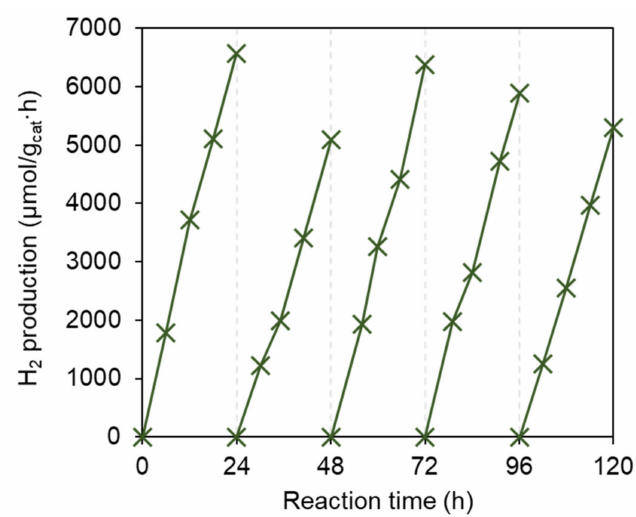
Figure 7. Recycle test showing hydrogen production results for B-Car / Pt-TiO 2 . Conditions: Xe lamp (0.15 mW / cm 2 ), 0.57 M ascorbic acid aq. (pH =